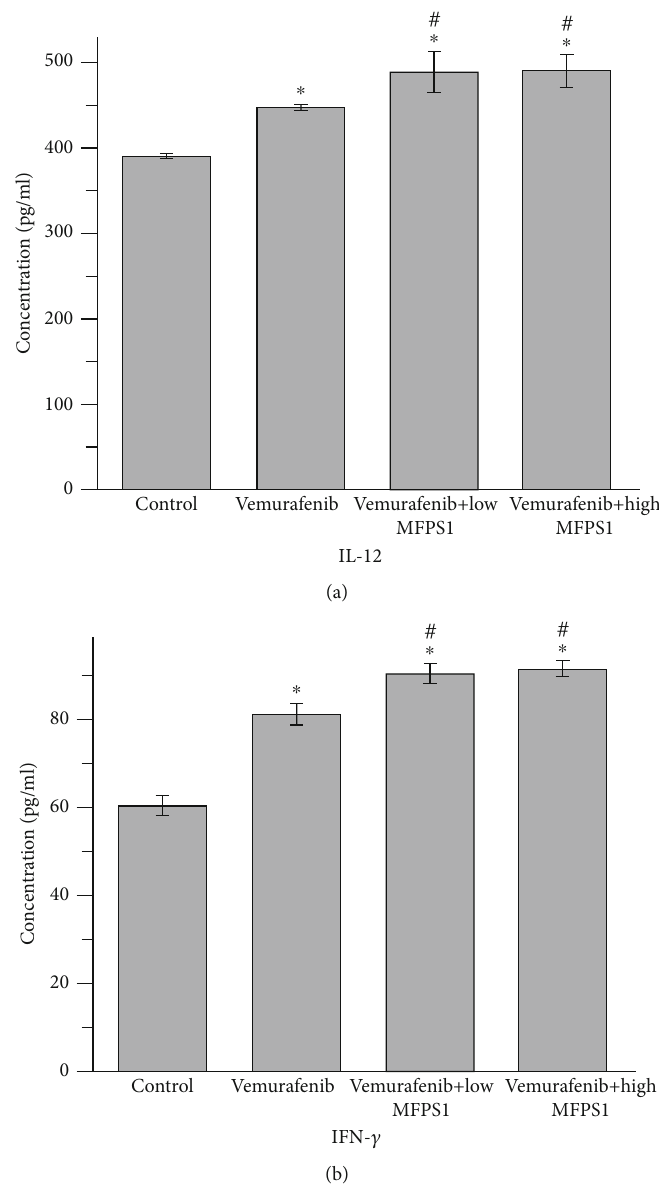
Figure 4: In vivo experiments, MFPS1 enhanced the secretion of cytokines IL-12 and INF- γ induced by Vemurafenib in PBMCs of melanoma-bearing mice. (a) The concentration of cytokine IL-12 in PBMCs of melanoma-bearing mice after drug treatment; (b) the concentration of cytokine INF- γ in PBMCs of melanoma-bearing mice after drug treatment. ∗ represents the normal group as the control: ∗ p ∗∗ p < 0 : 05 and < 0 : 01 ; # represents the Vemurafenib group as the control: # p < 0 : 05 and ## p < 0 : 01